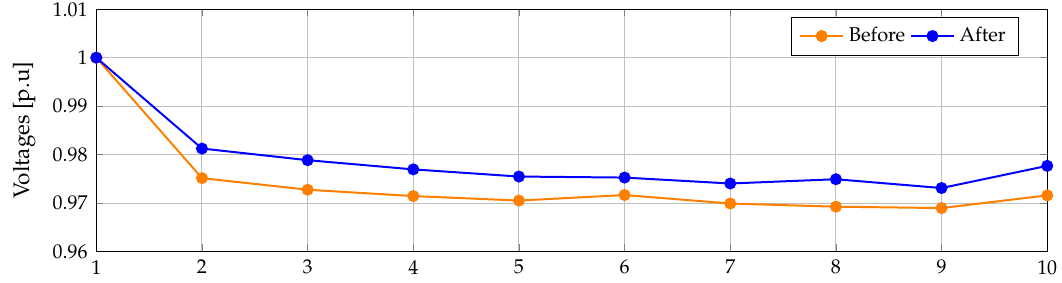
Figure 5. Voltage comparison between initial and final configurations in the 10-nodes test